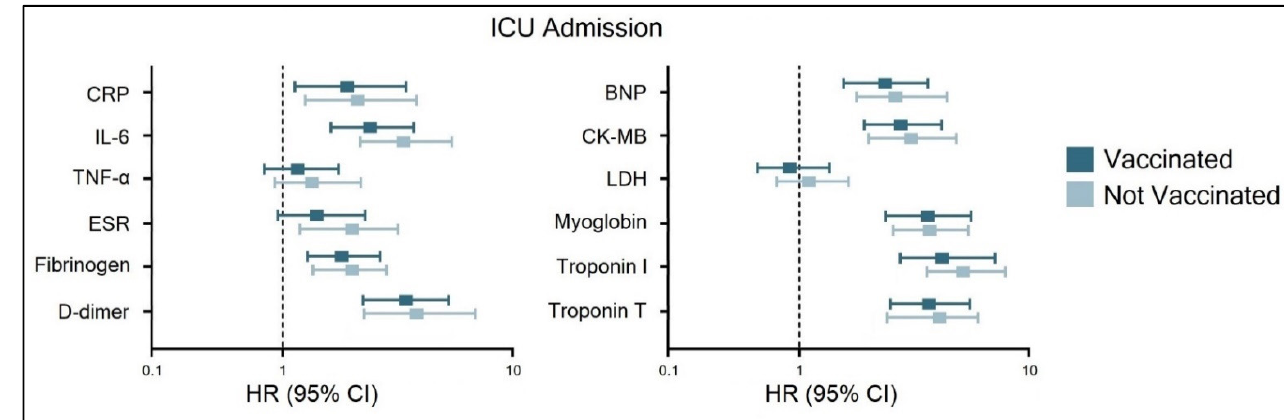
Figure 2. Risk factor analysis for ICU admission of heart failure hospitalized patients with COVID ‐ 19, stratified by status of COVID ‐ 19 vaccination.